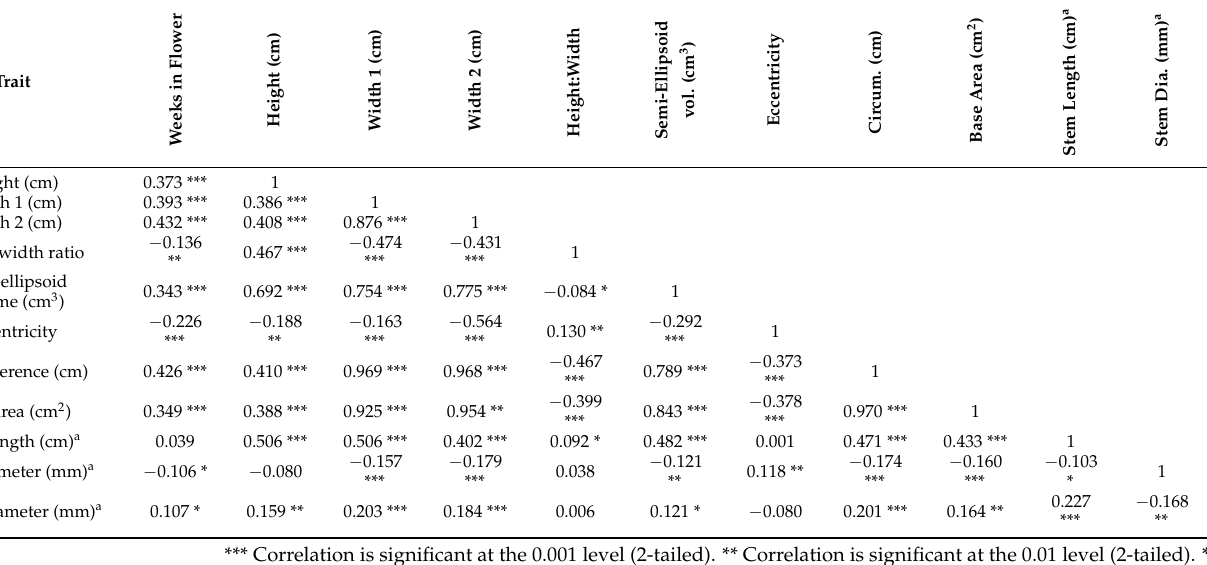
Table 7. Pearson correlations (r) for weeks in flower, height (cm), width 1 (cm), width 2 (cm), height:width ratio, semi-ellipsoid volume (cm 3 ), eccentricity, circumference (cm), base area (cm 2 ), stem length (cm), stem diameter (mm), flower diameter (mm) for flax populations of L. altaicum ,